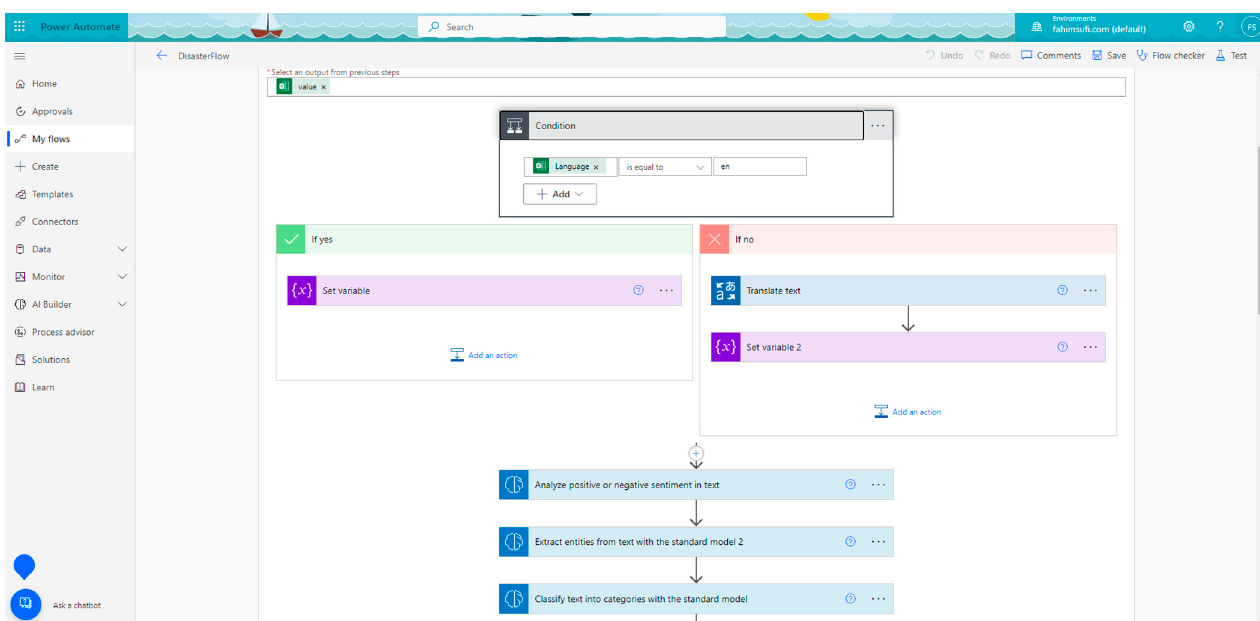
Figure 4. Implementation of complex AI-based algorithms, such as sentiment analysis, named entity recognition, category classification, language translation using Microsoft Power Automate cloud flow [57].